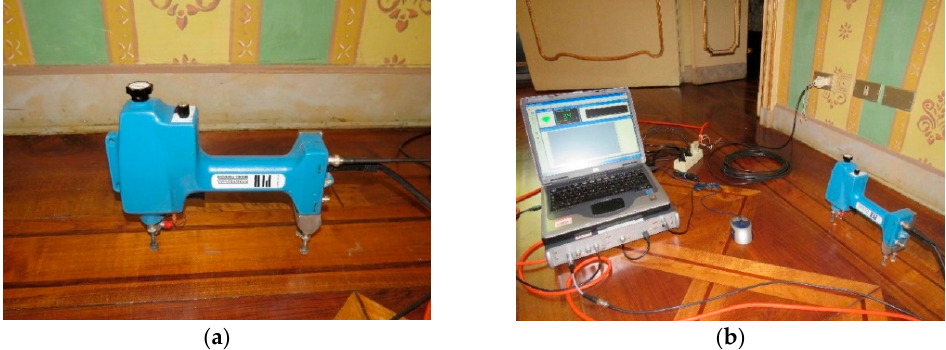
Figure 4. ( a ) The electric impact hammer; ( b ) the LMS Pimento multi-channel signal analyzer.